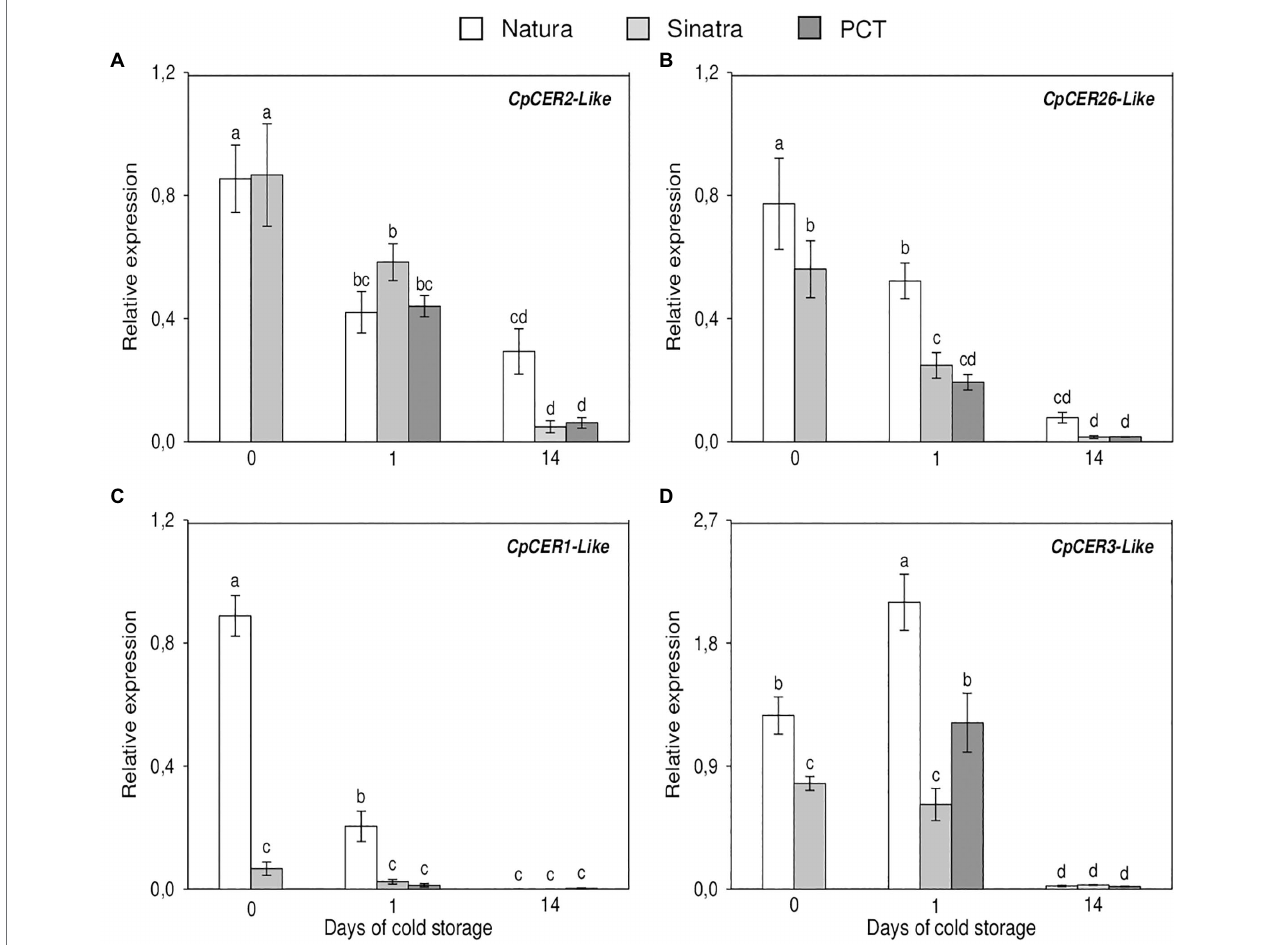
FIGURE 4 | Relative expression of the VLC-alkane biosynthesis genes CpCER2-like (A) , CpCER26-like (B) , CpCER1-like (C) , and CpCER3-like (D) in the exocarp of ‘Natura’ and ‘Sinatra’, including PCT ‘Sinatra’ fruit, at harvest and after 1 and 14 days of storage at 4 ° C. Data presented are means ± SE of triplicate samples of six fruits each. Different letters indicate significant differences according to Duncan’s test ( p <